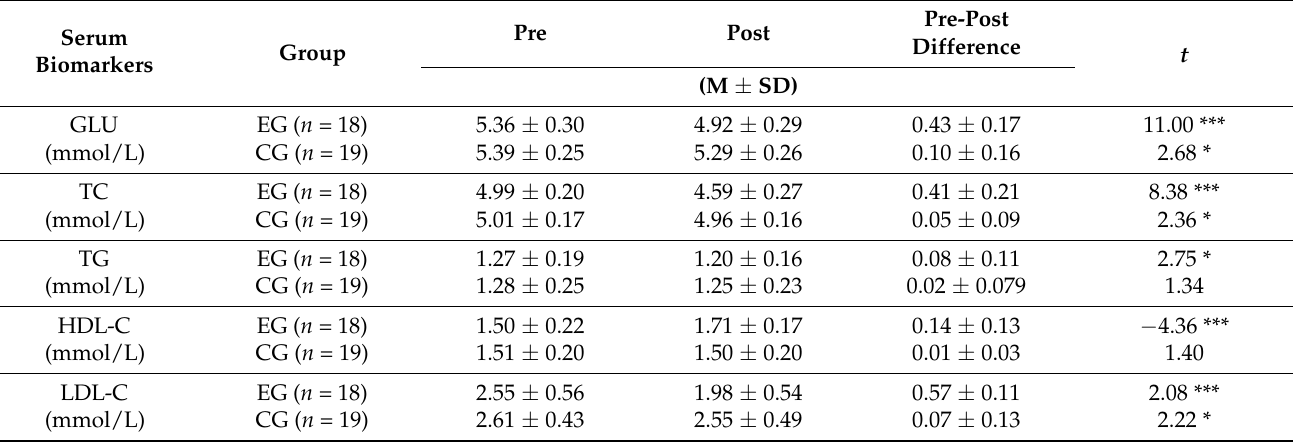
Table 5. Changes of serum biomarkers of experimental and control groups before and after 12 weeks ( t